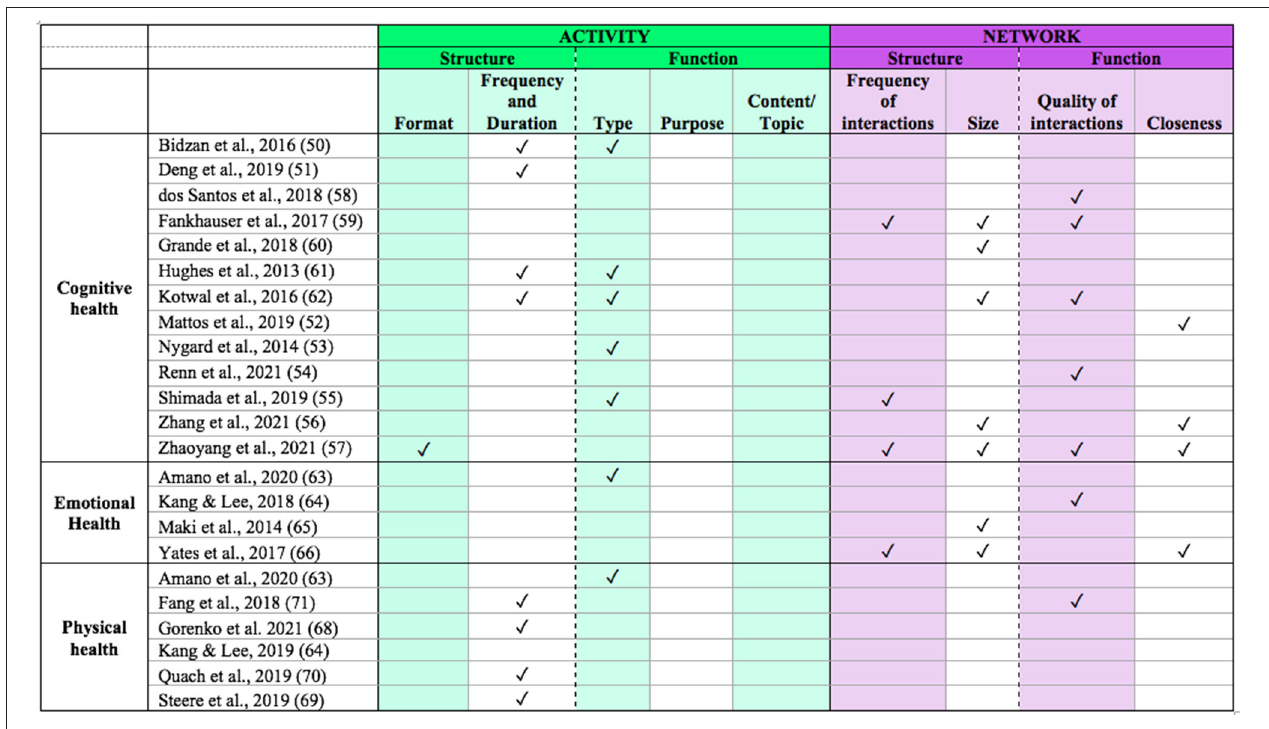
FIGURE 3 | Framework components addressed by each